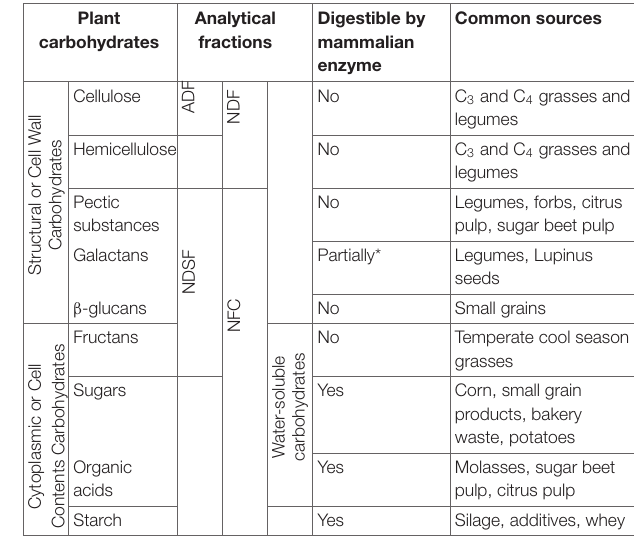
FIGURE 1 | A simple schematic to illustrate the carbohydrates located in plant cell walls or in the protoplasm, enclosed by the cell membrane.